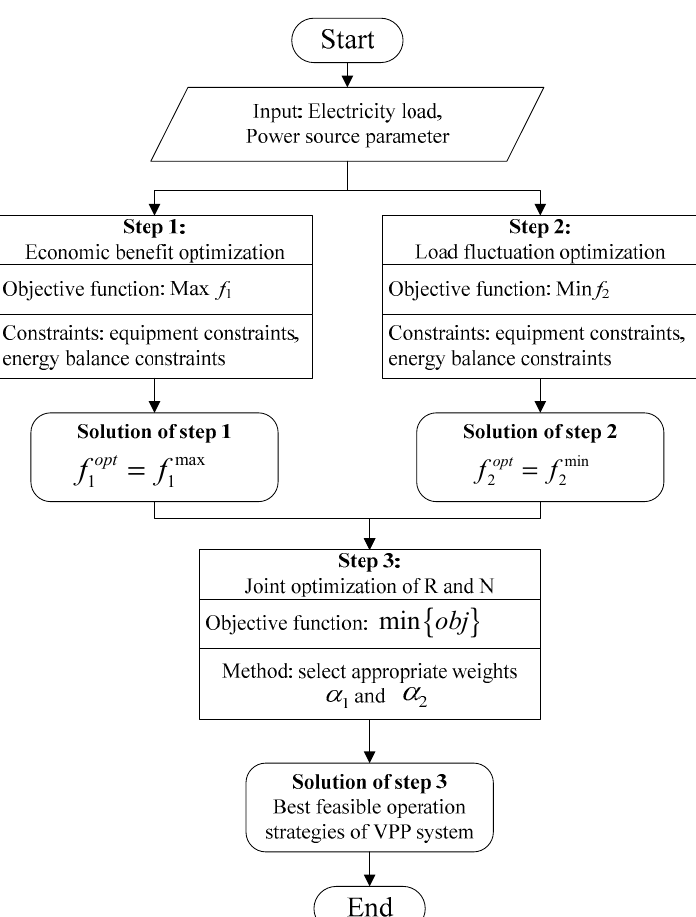
Figure 5. Flow chart of HES scheduling optimization model.